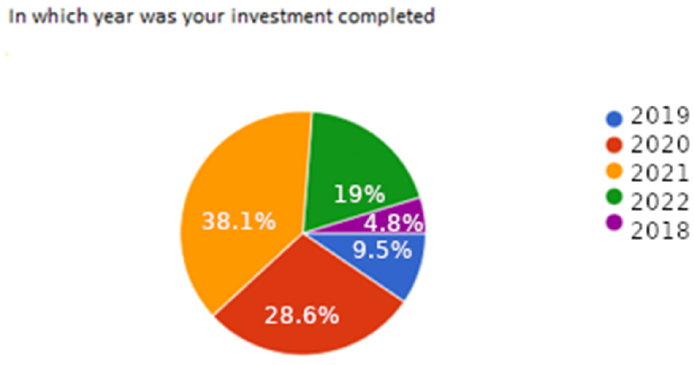
Figure 1. Year of establishment of the photovoltaic installation.